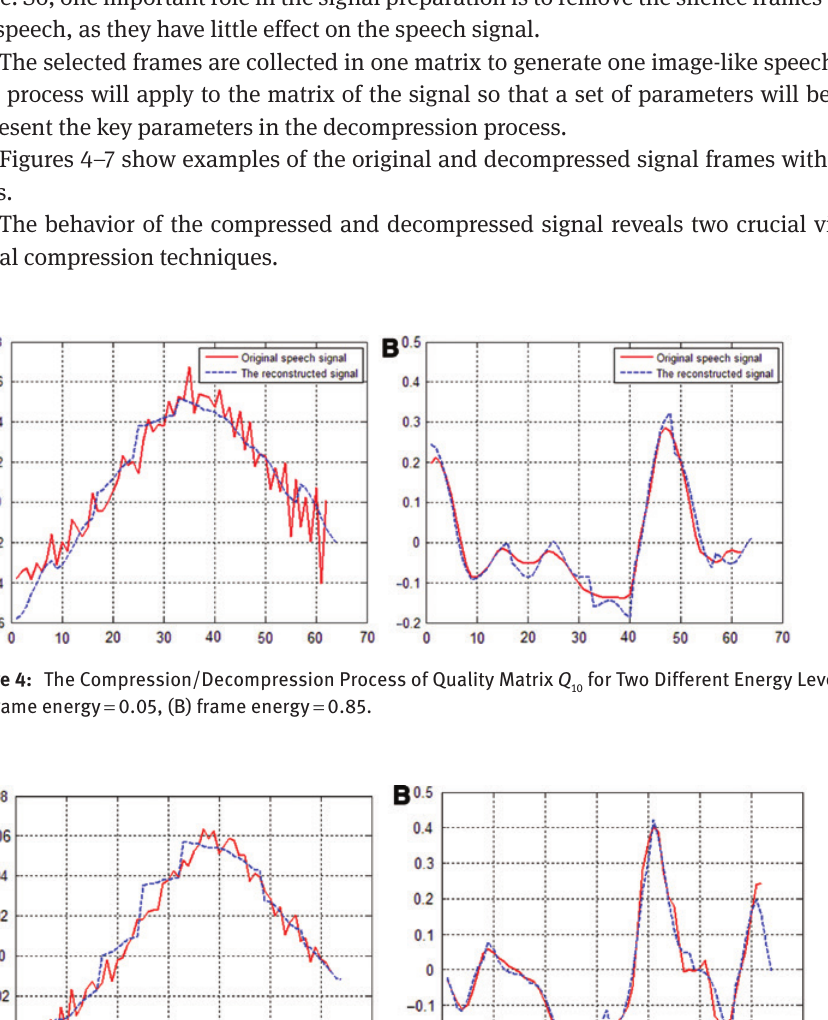
Figure 5: The Compression/Decompression Process of Quality Matrix Q (A) Frame energy = 0.08, (B) frame energy = 1.32.